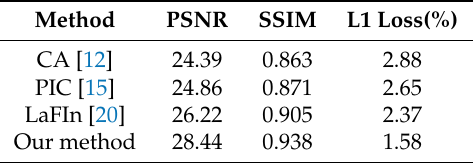
Table 1. The quantitative results on the CelebA-HQ test set consisting of 1000 face